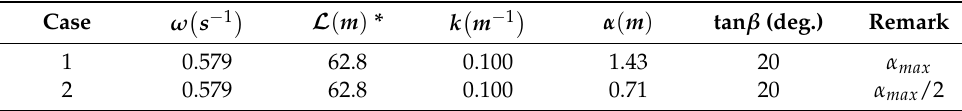
Table 1. Test case to examine the magnitude of mass transport.